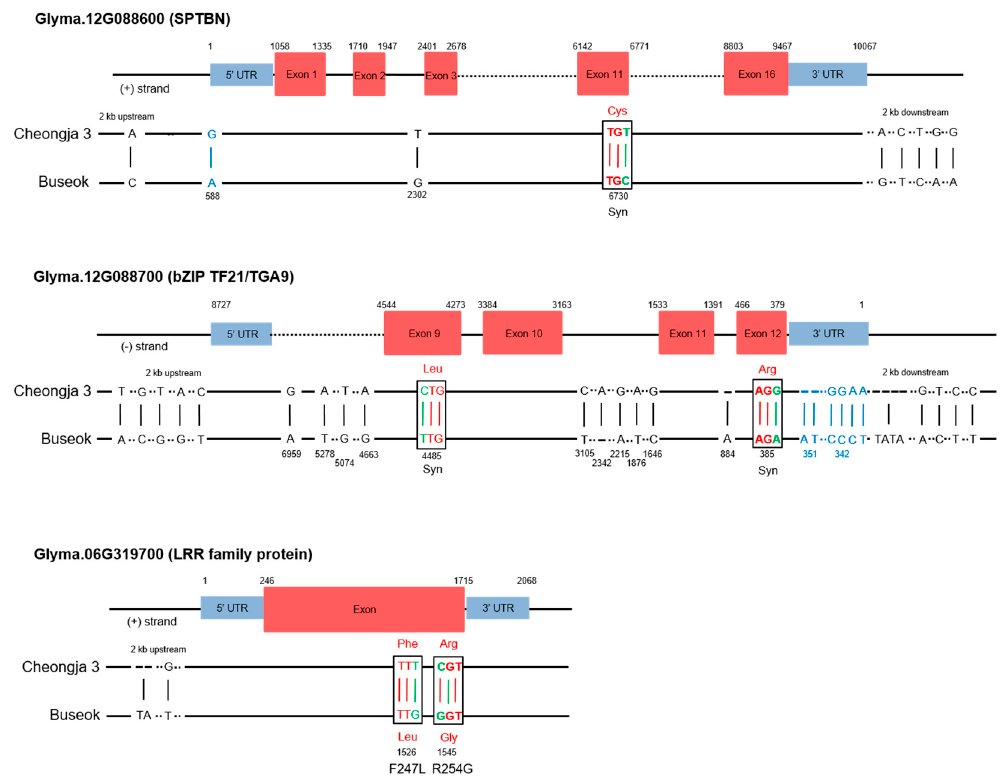
Figure 3. Structures of three genes encoding SPTBN (Glyma.12G088600), bZIP TF21/TGA9 (Glyma.12G088700), and LRR family protein (Glyma.06G319700), and single nucleotide polymorphisms (SNPs) in the mapping parents Cheongja and Buseok. Exons and untranslated regions (UTRs) are indicated by red- and blue-filled boxes, respectively. SNP positions, nucleotide replacements, and amino acid substitutions between Cheongja 3 and Buseok are presented. One and two SNPs in exons of SPTBN (Glyma.12G088600) and bZIP TF21/TGA9 (Glyma.12G088700), respectively, were synonymous. The SNPs T/G and C/G in exons of Glyma.06G319700 (LRR family protein) caused amino acid replacements of Phe to Leu and Arg to Gly at the 247th and 254th residues, respectively.